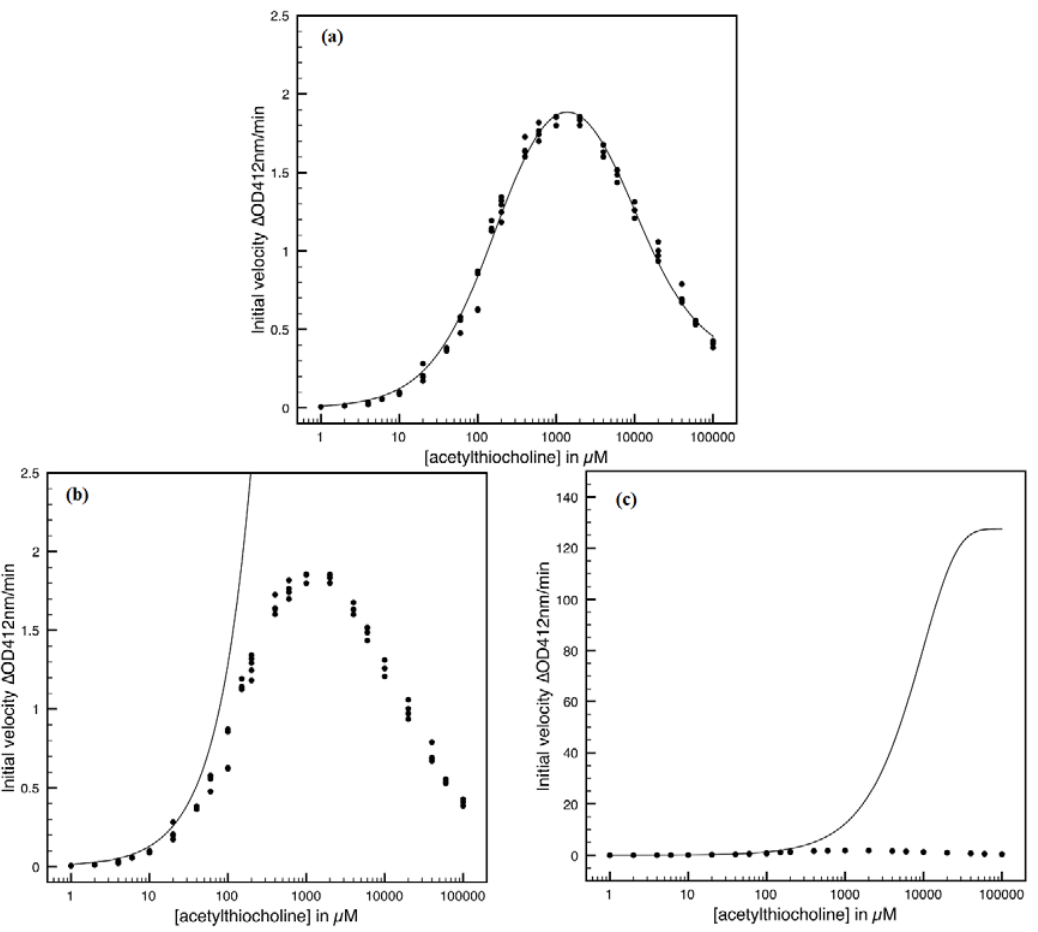
= 190 ± 30 µM; K = 8,700 S SS